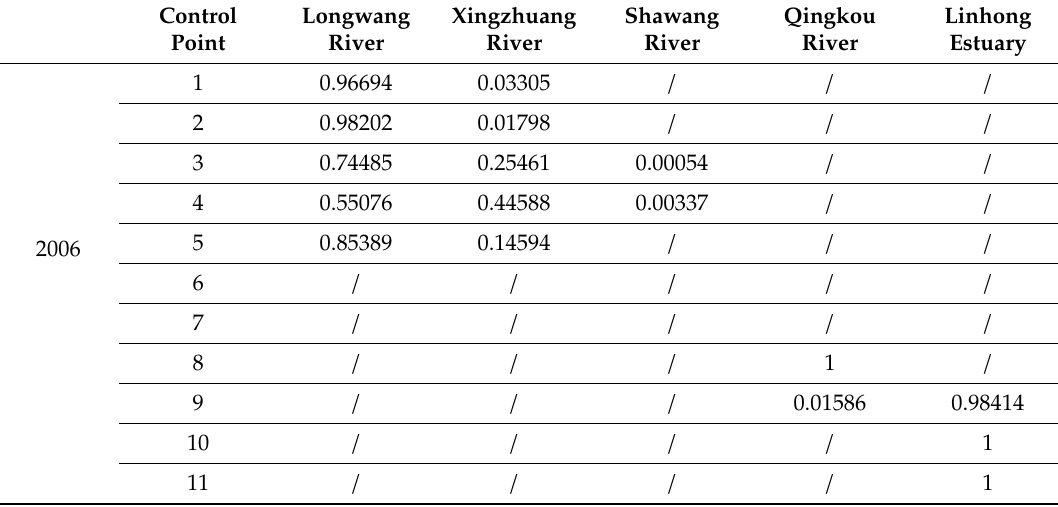
Table 4. The share ratio of each river flowing into the ocean at each control point in 2006 and